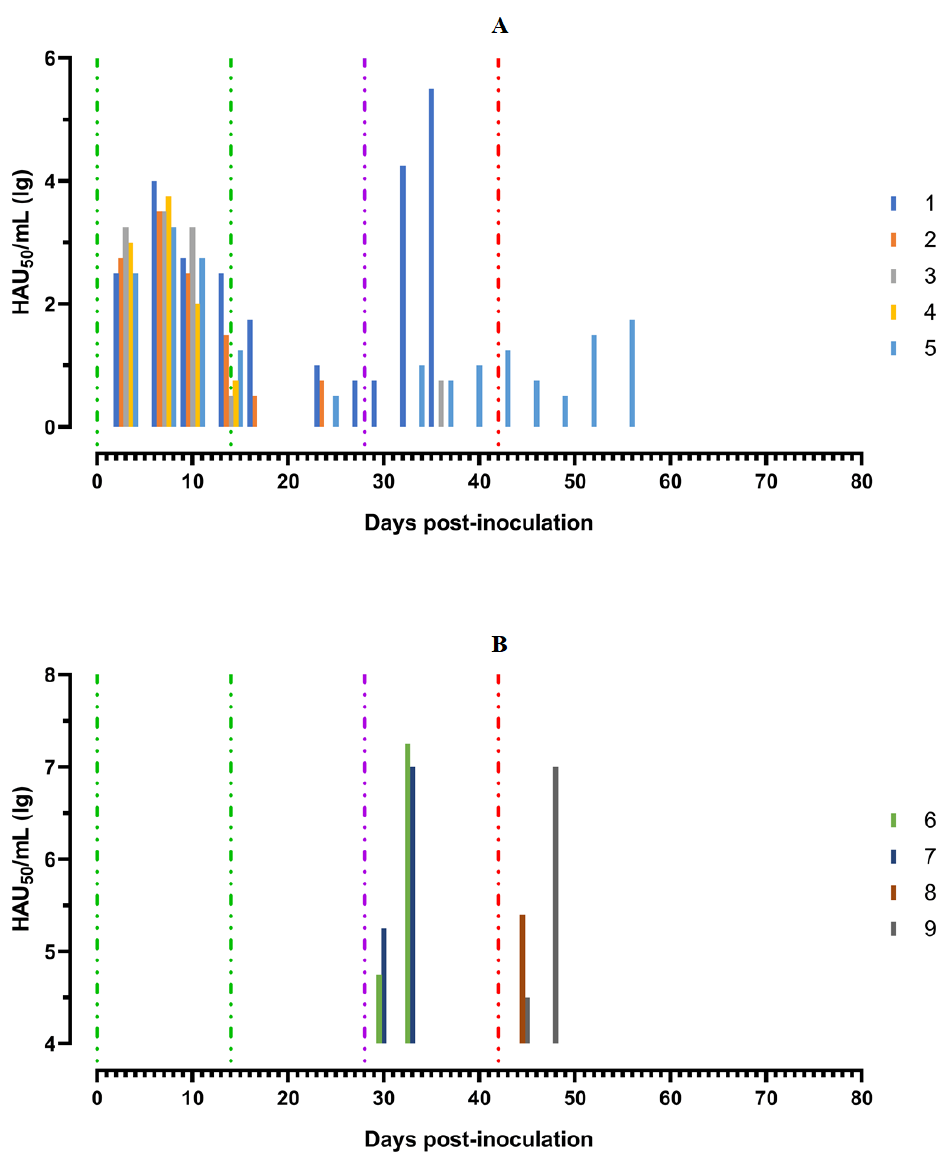
Figure 5. Virus titers in blood samples, obtained from pigs: ( A ) group 1 (## 1 – 5) inoculated with 10 6,0 HAU 50 ASFV – Katanga-350 and challenged at a dose of 10 3.0 HAU 50 ASFV – Lisbon-57 and ASFV – Stavropol 08/01; ( B ) group 2 challenged with ASFV – Lisbon-57 (## 6, 7) and group 3 challenged with ASFV –Stavropol 08/01 (## 8, 9). Each bar represents an individual animal’s values. Vertical dashed lines: green — days of inoculation of ASFV – Katanga-350, purple — challenge by ASFV – Lisbon-57, red — infected by ASFV – Stavropol 08/01 strain. After challenge of pigs from groups 1 (## 1 – 5) and 2 (## 6, 7) by the virulent Lisbon- 57 strain, the animals #1, #6 and # 7 had the following typical clinical signs of acute form